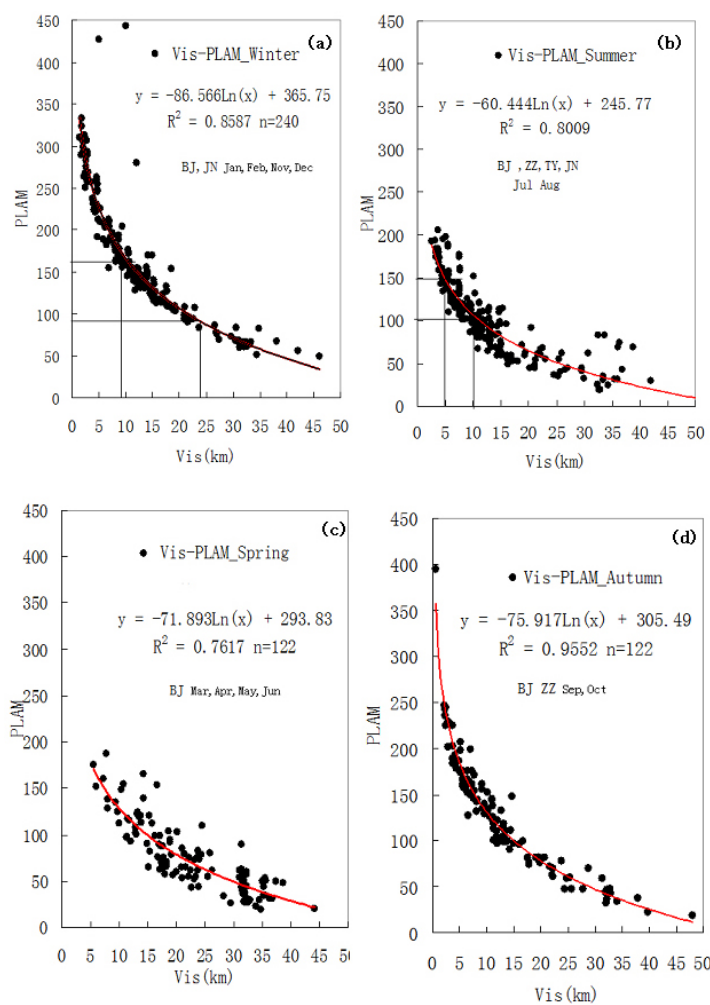
Figure 4. Correlation analysis of PLAM/h index and visibility in winter (a) , summer (b) , spring (c) , and autumn (d)